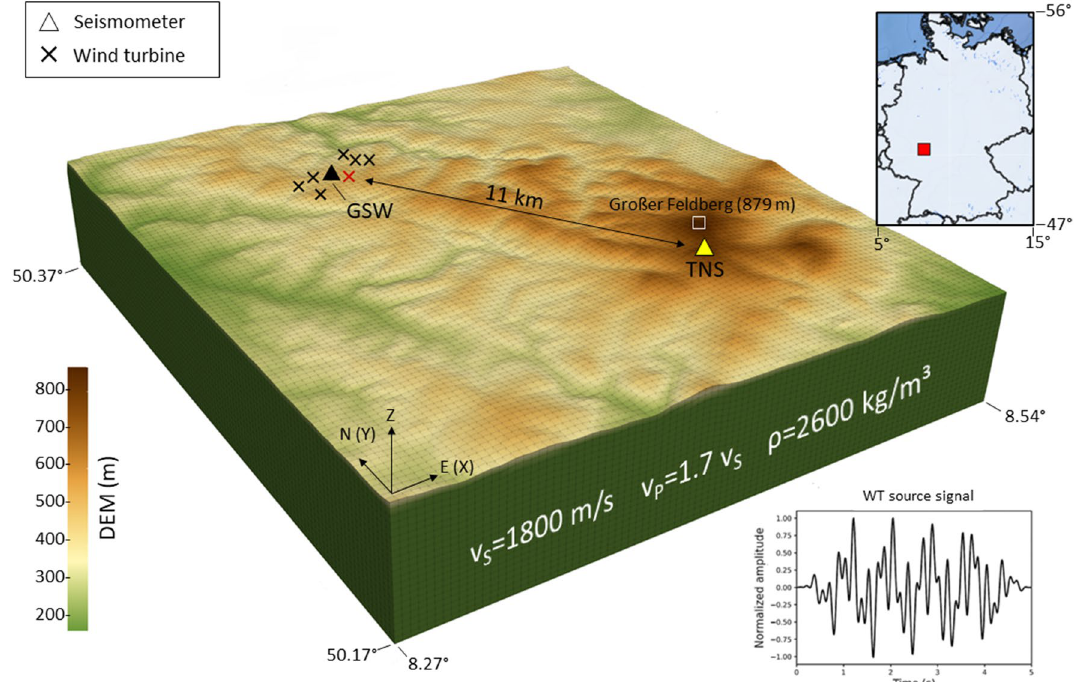
Figure 1. Model setup with a digital elevation model (DEM) of the local topography. The source time function of the WT used for modelling (bottom right) is obtained by summing three sinusoidal curves with frequencies of 1.15 Hz, 3.5 Hz and 6.0 Hz, each with a duration of 5 s. The temporary seismic station (GSW) is located within the Weilrod WF. The permanent seismic station (TNS) is located approximately 11 km from the WF atop the Kleiner Feldberg (about 1.3 km to the southwest of Grosser Feldberg). The coordinates of the model are given in WGS84. The thin grey lines indicate the computational mesh elements. The position of the WT used for simulations with one source only is marked by red cross. The computational model covers an area of 17 km × 19 km and a depth of 3.2